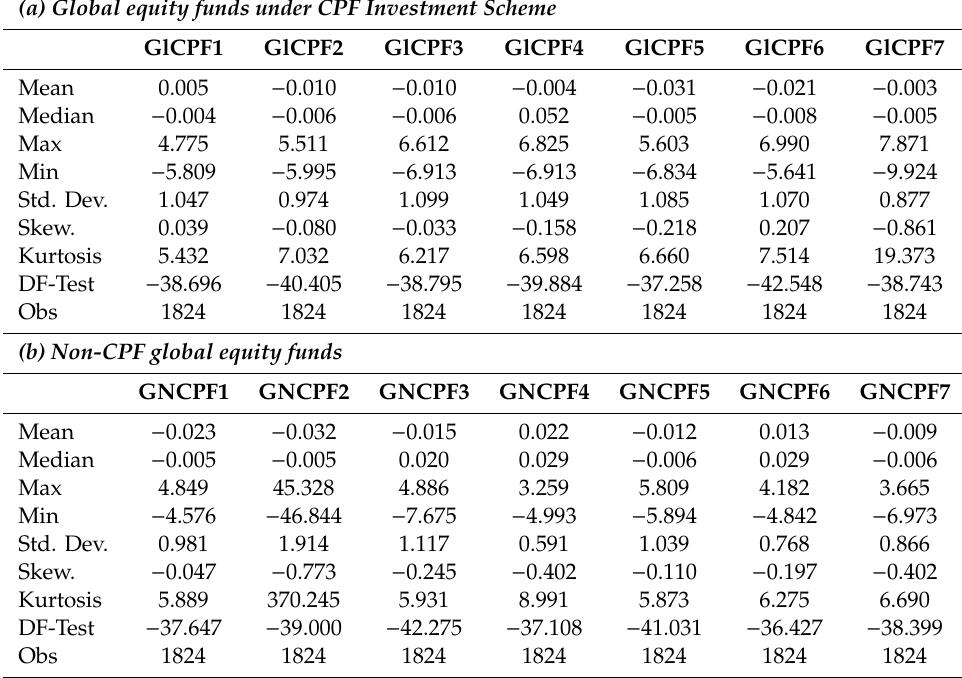
Table 2. Descriptive statistics of the excess returns of global equity funds under the CPF Investment Scheme and non-CPF global equity funds.